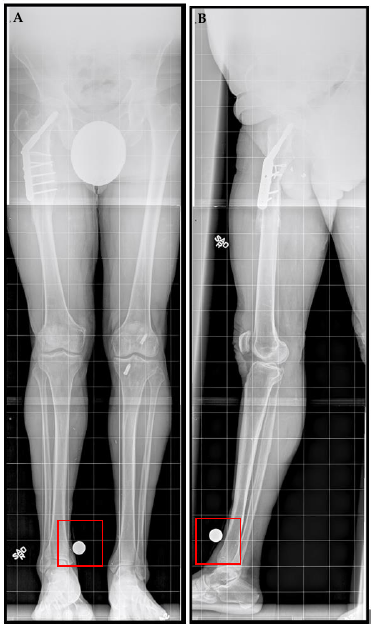
Figure 1. Posttraumatic femoral lengthening in a 71-year-old male patient, shown preoperatively. ( A ) Anteroposterior bilateral long leg and ( B ) right long leg lateral prior to the insertion of the Precice MILN. Gray dots on the bottom represent X-Ray calibration spheres. A right femoral osteoplasty was performed and a Precice MILN was inserted using the methods described above (Figure 2). The patient began lengthening as instructed on postoperative day five. He attended physical therapy and took vitamin D and calcium supplementation, as well as oxycodone as needed for pain management. Initial ROM of the knee joint was restricted from 0 – 50°, but full range was regained two months after surgery. He finished distraction 46 days after surgery (Figure 3). The patient completed consolidation 152 days after surgery and experienced no complications. At his latest fol- low-up appointment, his long leg films (Figure 4) demonstrated complete healing, remod- eling, and equal limb length. The patient has returned to his active lifestyle, including skiing, and reported that he felt better on his bike and skis.